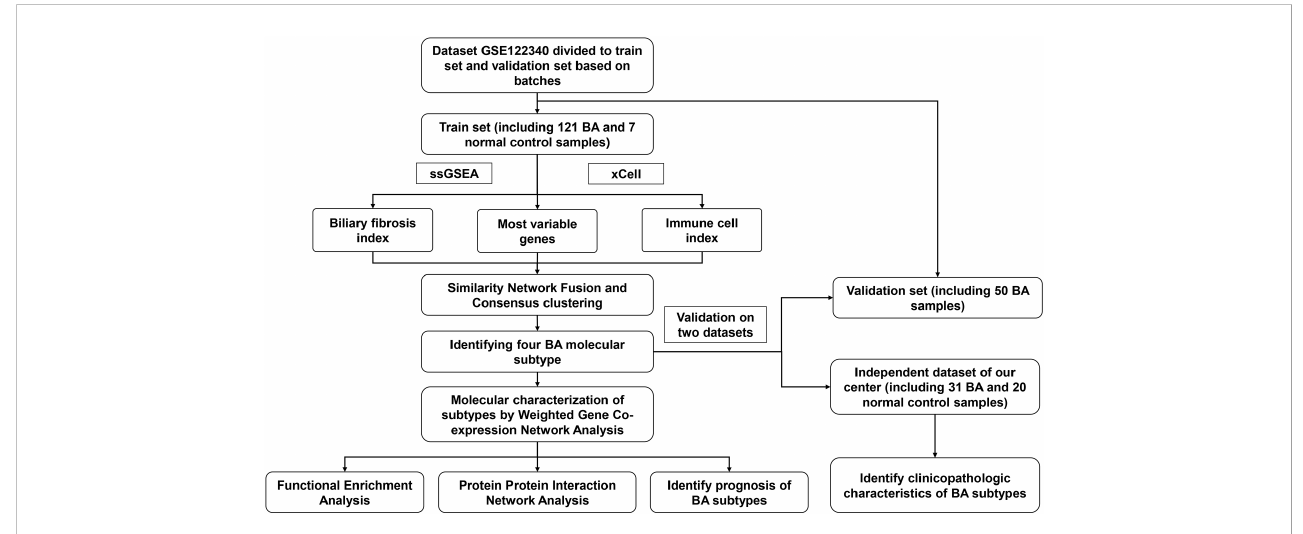
FIGURE 1 The fl owchart of the integration